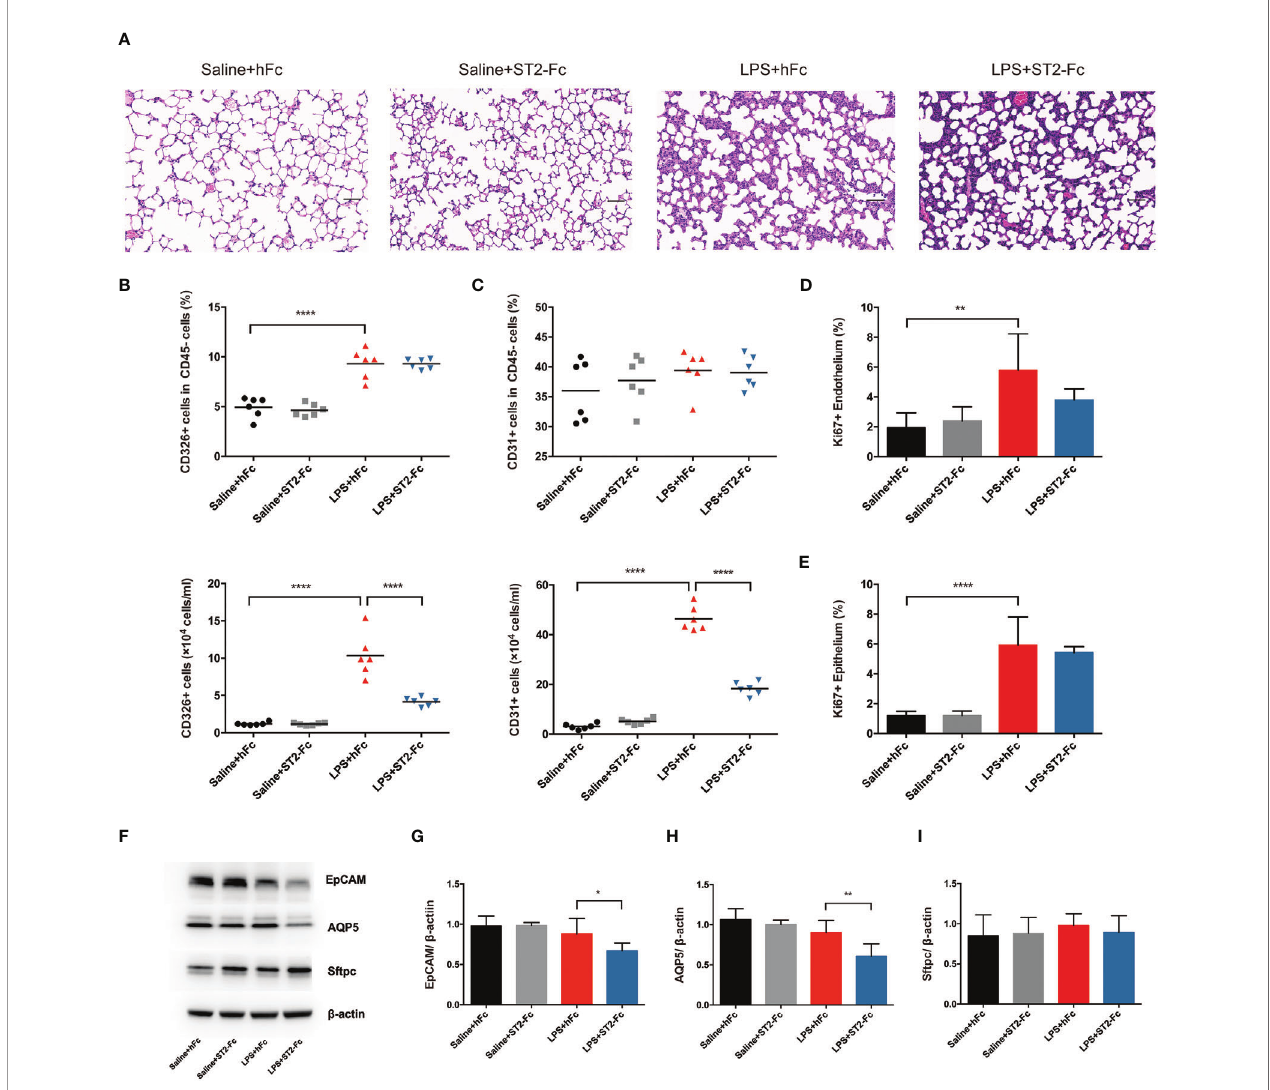
FIGURE 6 | Involvement of the IL-33:ST2 axis in pulmonary regeneration activities. (A) Histopathological staining. Representative HE staining of lung sections is shown 4 days after LPS-induced ARDS. Original magni fi cation = 200×, scale bar represents 50 m m. (B) Fraction and numbers of epithelial cells (CD45 − CD326 +CD31 − cells) in the lung suspension by fl ow cytometric analysis. (C) Fraction and numbers of endothelial cells (CD45 − CD326 − CD31+ cells) in the lung suspension by fl ow cytometric analysis. (D) Summary data for proliferation of endothelium (CD45 − CD326 − CD31+Ki67+ cells) by fl ow cytometric analysis. (E) Summary data for proliferation of the epithelium (CD45 − CD326+CD31 − Ki67+ cells) by fl ow cytometric analysis. (F – I) Lung epithelium-associated protein. EpCAM, AQP5, and Sftpc protein expression was quanti fi ed by Western blotting. The observation time was on day 4. For all panels: mean ± S.D. *p ≤ 0.05; **p ≤ 0.01; and ****p ≤ 0.0001 for one-way analysis of variance with the Bonferroni post hoc test for multiple t-tests. A value of p < 0.05 was considered statistically signi fi cant. n = 6 mice per